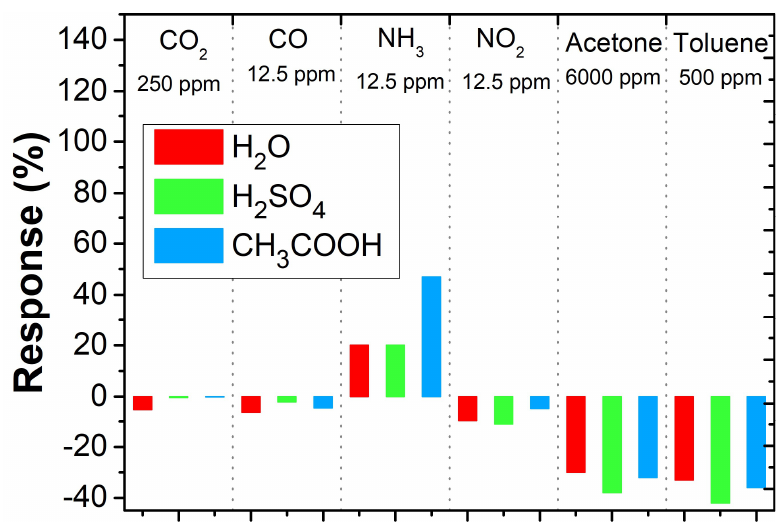
Figure 15. Overview of PANI layer response toward tested gasses and vapors.